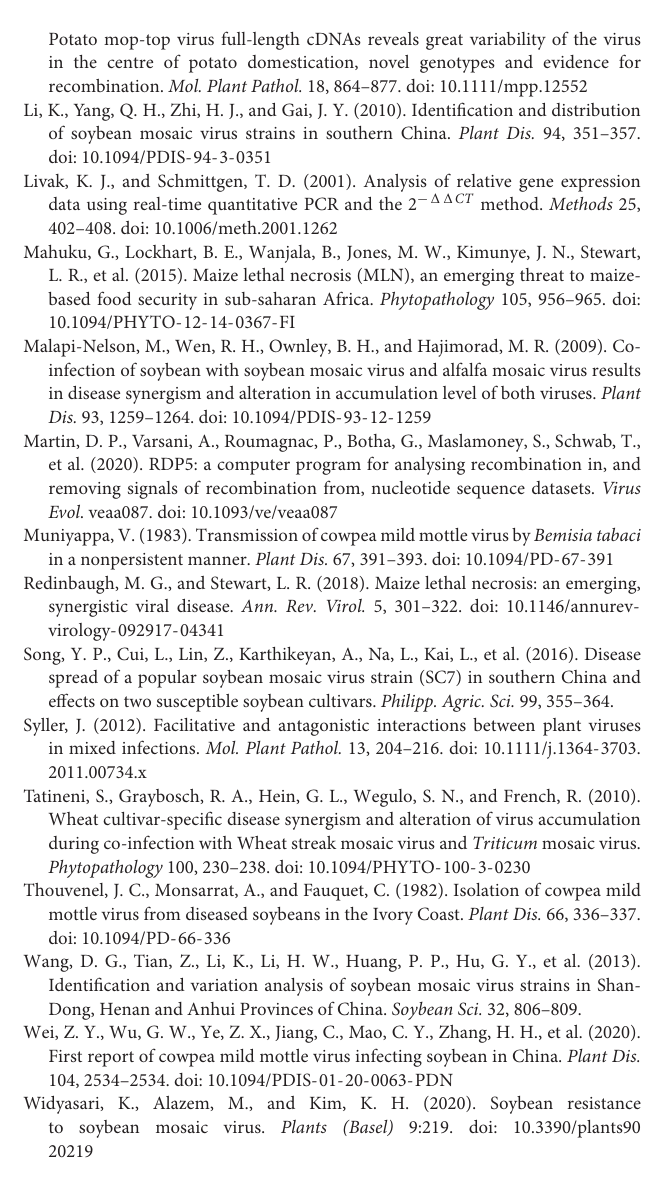
Supplementary Figure 1 | Detection of CPMMV and SMV in the total RNA of symptomatic field soybean samples as shown by RT-PCR. Supplementary Figure 2 | The genome organization of SMV isolates. Supplementary Figure 3 | NJ-phylogenetic relationships among the ORFs of CPMMV isolates from different countries. Supplementary Figure 4 | Pairwise identity matrix of CPMMV isolates for each open reading frame (ORF). Supplementary Figure 5 | Phylogenetic trees analysis based on different nucleotide fragments of CPMMV isolates from China. Supplementary Figure 6 | Recombination events among the SMV isolates. Supplementary Table 1 | Genomic organization of the 11 CPMMV isolates described in this study. Supplementary Table 2 | List of primer sequences used in this